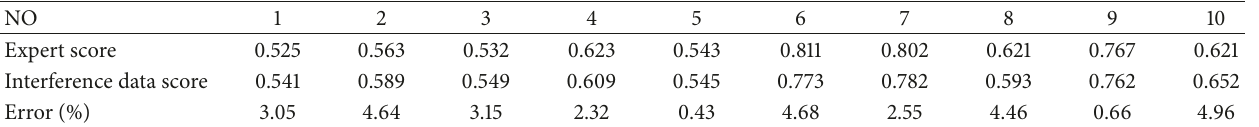
Table 13: Error test of interference data score and expert score.